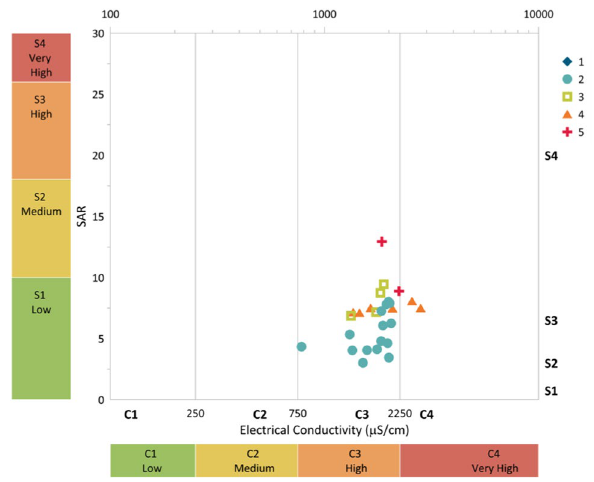
Fig. 2 US salinity diagram for reclaimed wastewater